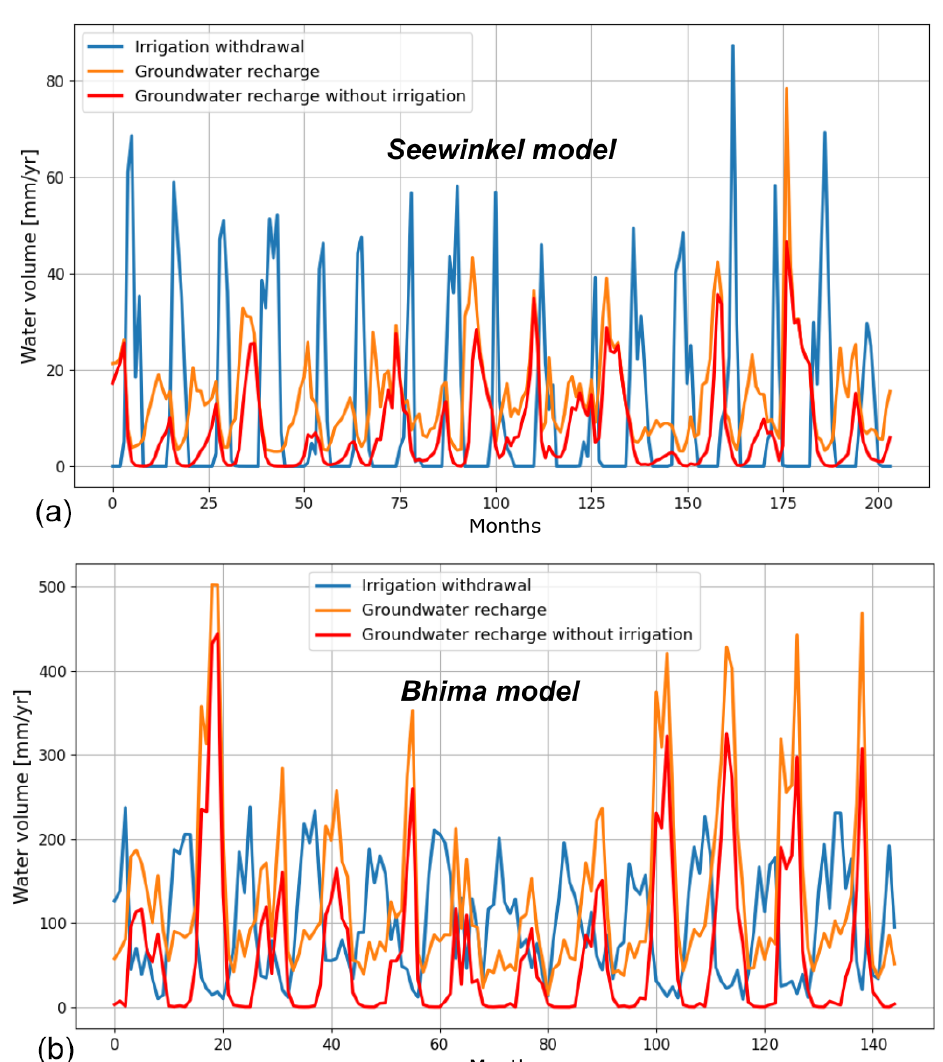
Figure A1. Comparison between average monthly recharge with and without irrigation in irrigated areas in Seewinkel (a) and Bhima (b) . Irrigation withdrawal is also represented in